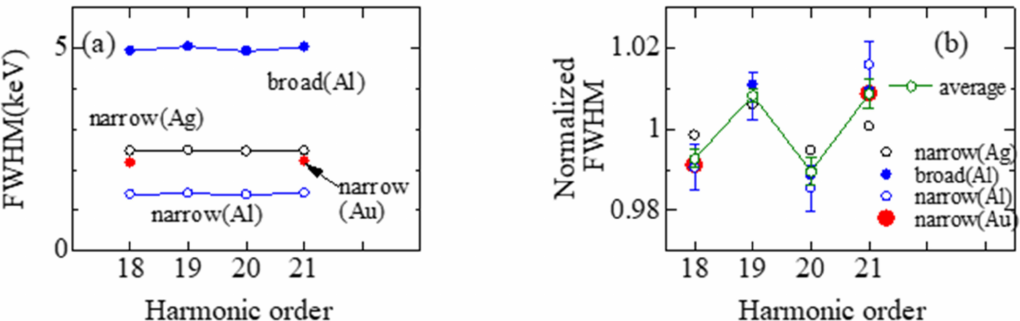
Figure 4. ( a ) Dependence on harmonic order of undulator for FWHMs of Compton scattering spectra (Width_1 (broad) and Width_2(narrow)). The estimated errors are about 0.6%, which is within the dot size ( b ) normalized values of the FWHMs in ( a ). The typical errors are shown for Width_2(narrow) of Al. The error of average is also